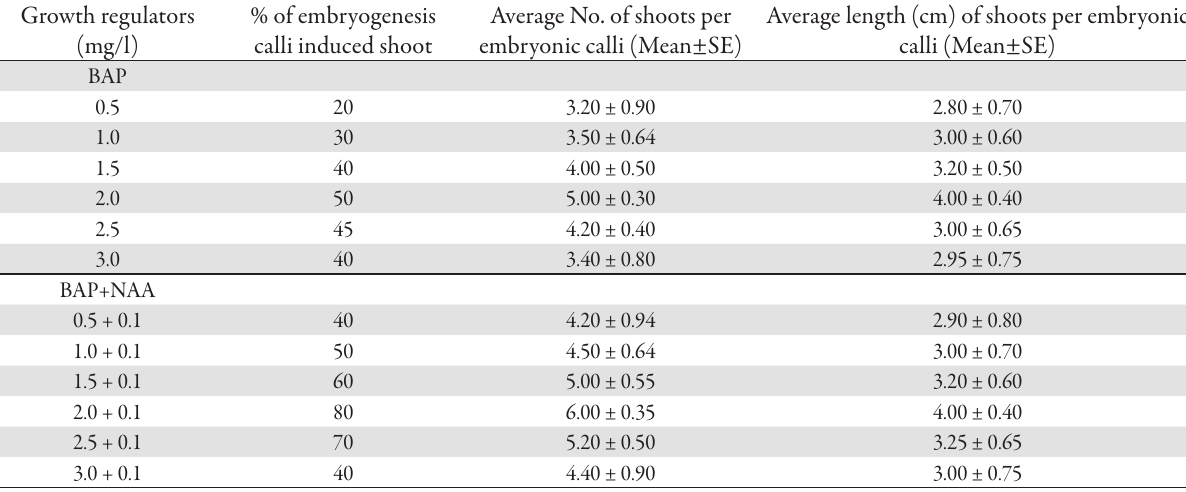
Tab. 4. Effect of BAP and NAA on shoot formation from regenerated embryos. There were 3 replications for each sample Growth regulators